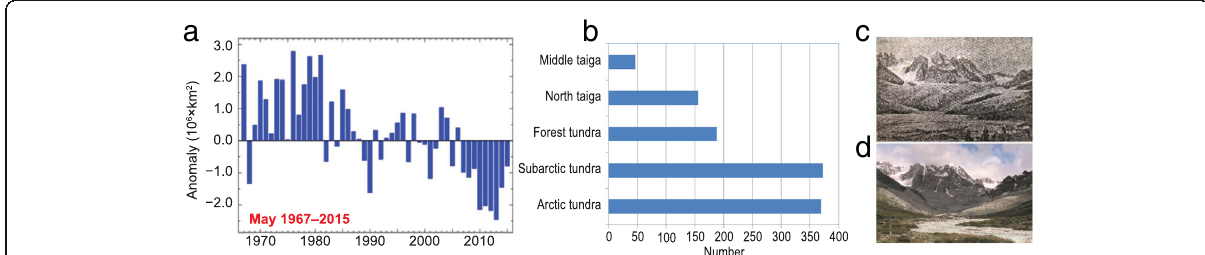
Fig. 7 Manifestations of the cryosphere retreat. a Spring snow cover extent anomalies over Eurasia (Blunden and Arndt 2016). b Number of newly emerging thermokarst lakes in West Siberia during the 1973 – 2013 period (Polishchuk et al. 2015). c-d Altai Mountains on the boundary of Russia, China, and Mongolia; Kozlov glacier in 1906 and 2013, respectively (Syromyatina et al.